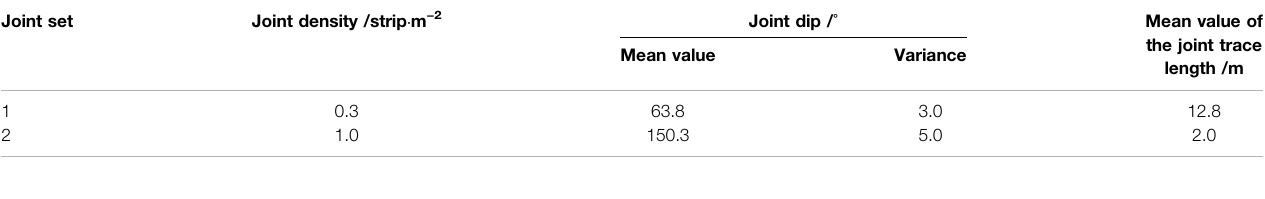
TABLE 2 | Mechanical